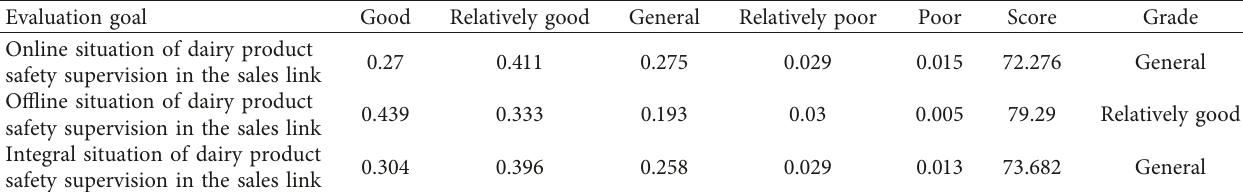
Table 8: Scores of the online, offline, and integral safety supervision of dairy products in the sales link.